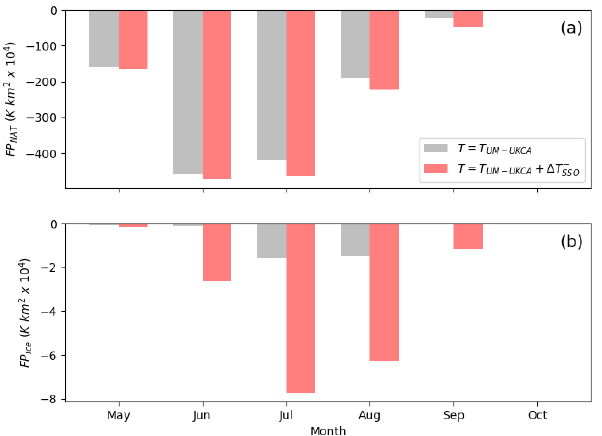
Figure 7. Histograms showing the monthly mean formation po- tential ( × 10 4 Kkm 2 ; see (1) for definition) for PSCs made from (a) NAT and (b) ice particles during each individual month from May to October at an altitude of 20.4km for the perturbation run (red) and the control run (grey), i.e. for T equal to either T UM − UKCA + (cid:49)T − (perturbation run with the parameterisation SSO scheme on) or T UM − UKCA (control run with the parameterisation scheme off). Note that the results are computed within the box indi- cated in Fig.